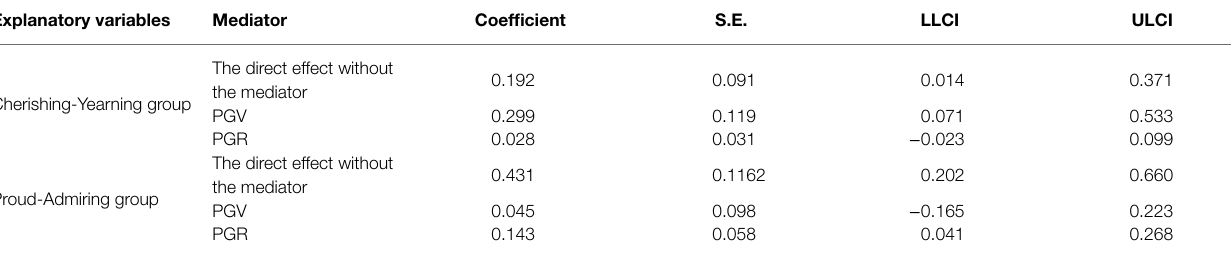
TABLE 4 | Mediating effect of theoretical model.